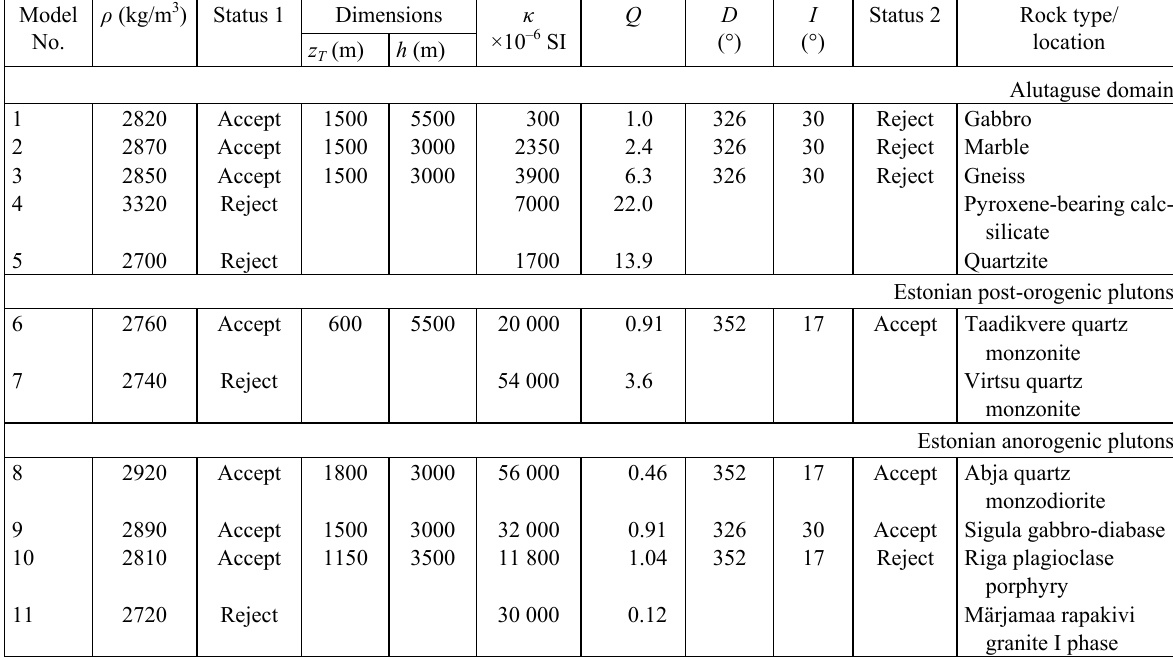
Table 1. Model physical properties and modelling results Dimensions